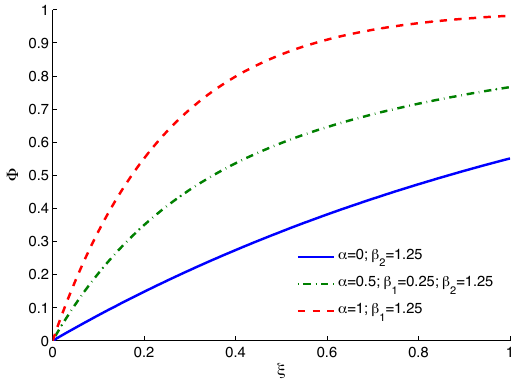
Figure 2. Adopted degradation function under different sets of